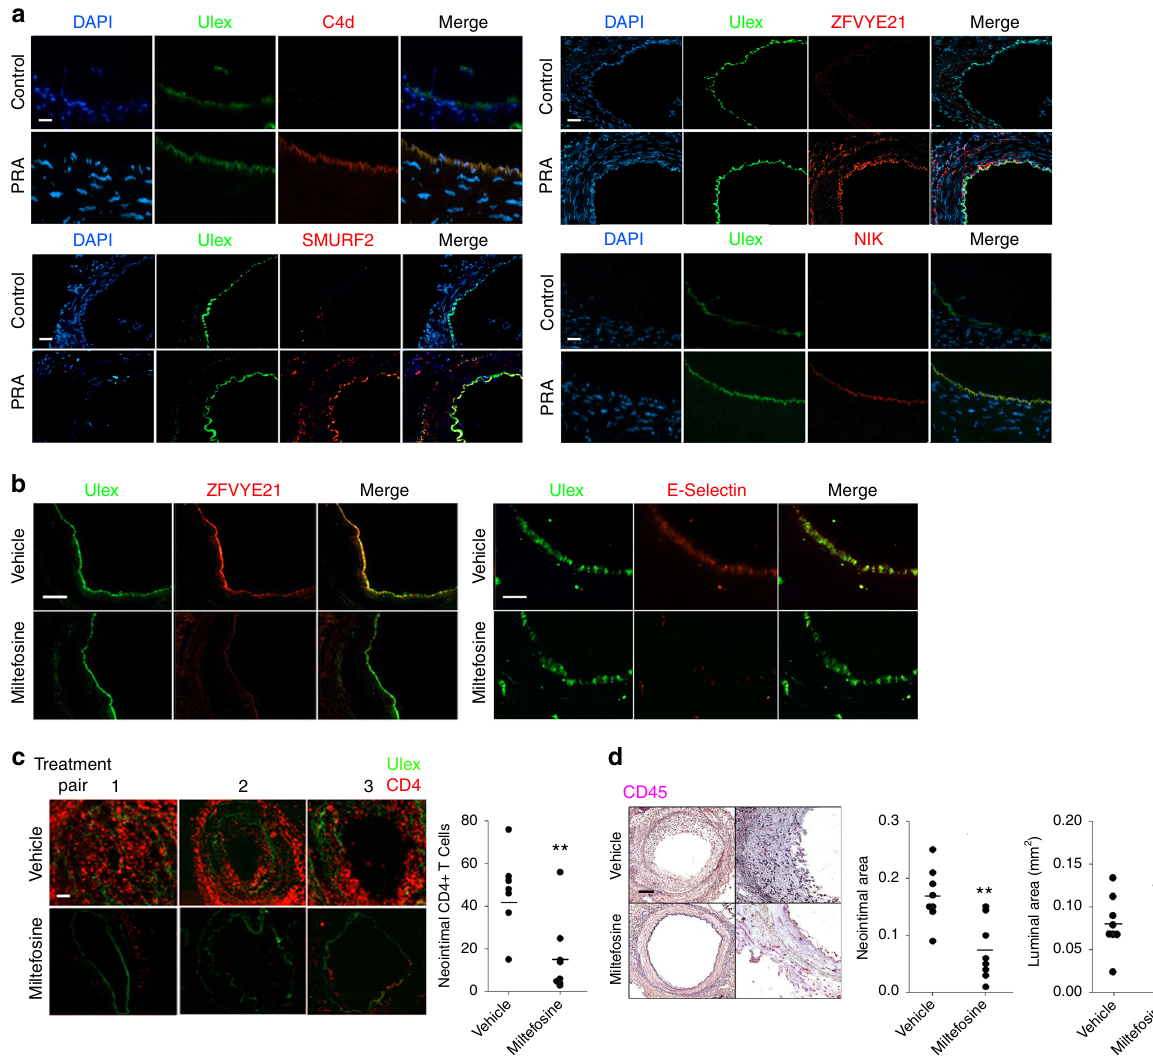
Fig. 5 ZFVYE21 regulates complement-mediated in fl ammation in vivo. Coronary artery segments were implanted as interposition grafts in descending aortae of SCID/bg immunode fi cient mice who received 200 μ L IgG-depleted ( n = 4) or intact panel reactive antibody (PRA) sera ( n = 4) intravenous prior to graft harvest and immuno fl uorescence analysis as indicated ( a , scale bar: left 200 μ m, right 400 μ m). Human coronary artery xenografts were pretreated with miltefosine (40 mg/kg once daily intraperitoneally for 3 days) prior to injection of PRA sera. Grafts were harvested 24 h afterwards and analyzed for intimal expression of ZFYVE21 and E-selectin ( b , n = 3, scale bar: left 200 μ m, right 400 μ m). Human coronary artery segments treated with vehicle ( n = 8) or miltefosine ( n = 8) were exposed to PRA sera and then reparked as interposition xenografts in the descending aortae of SCID/bg immunode fi cient mice engrafted with human T cells. Fourteen days posttransplant, neointimal CD4 + T cells were enumerated ( c , scale bar: 800 μ m), and neointimal and luminal areas were calculated ( d , scale bar: 800 μ m). ** p < 0.001, Student ’ s t test ** p <